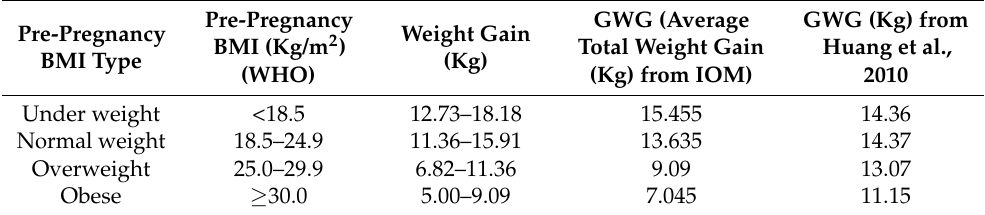
Table 5. Comparison of gestational weight gain (GWG) for different types of BMI, obtained from two